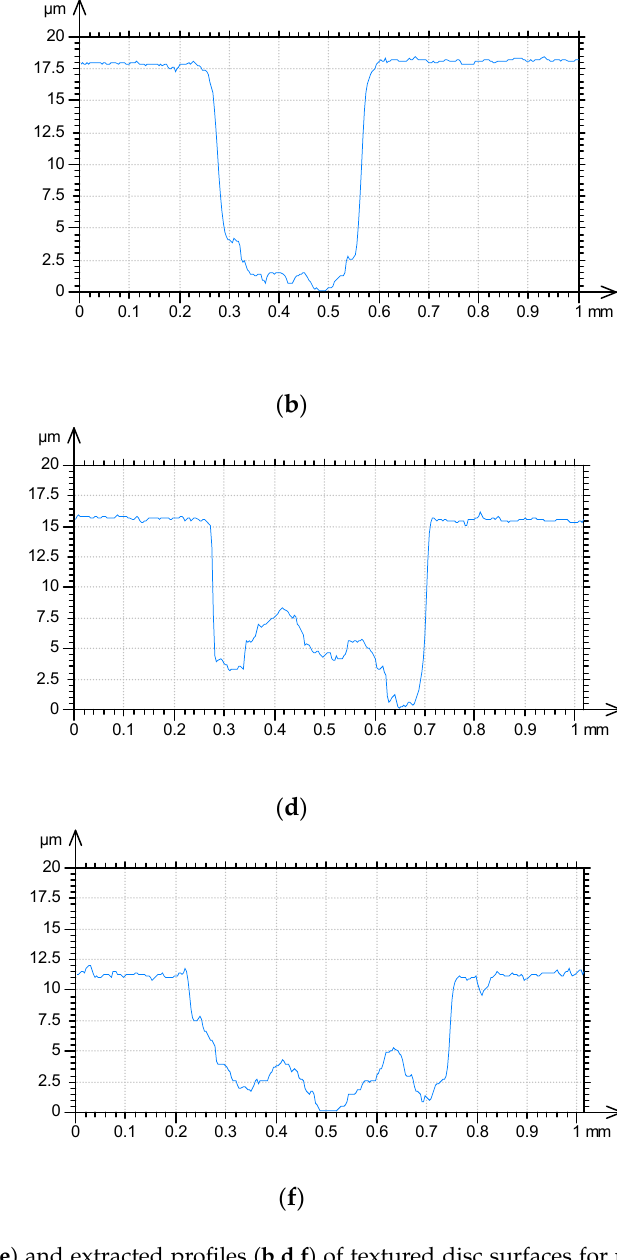
where load and frequency were set to 0. Such a break was necessary for temperature stabilization. The number of test repetitions was 3.